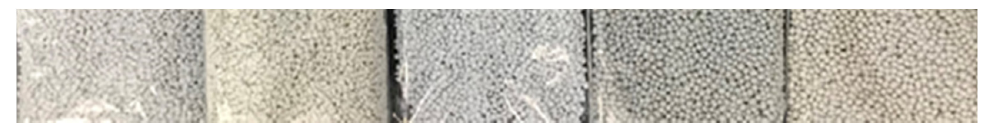
Figure 13. PCR resin color variation (image courtesy of Amcor).